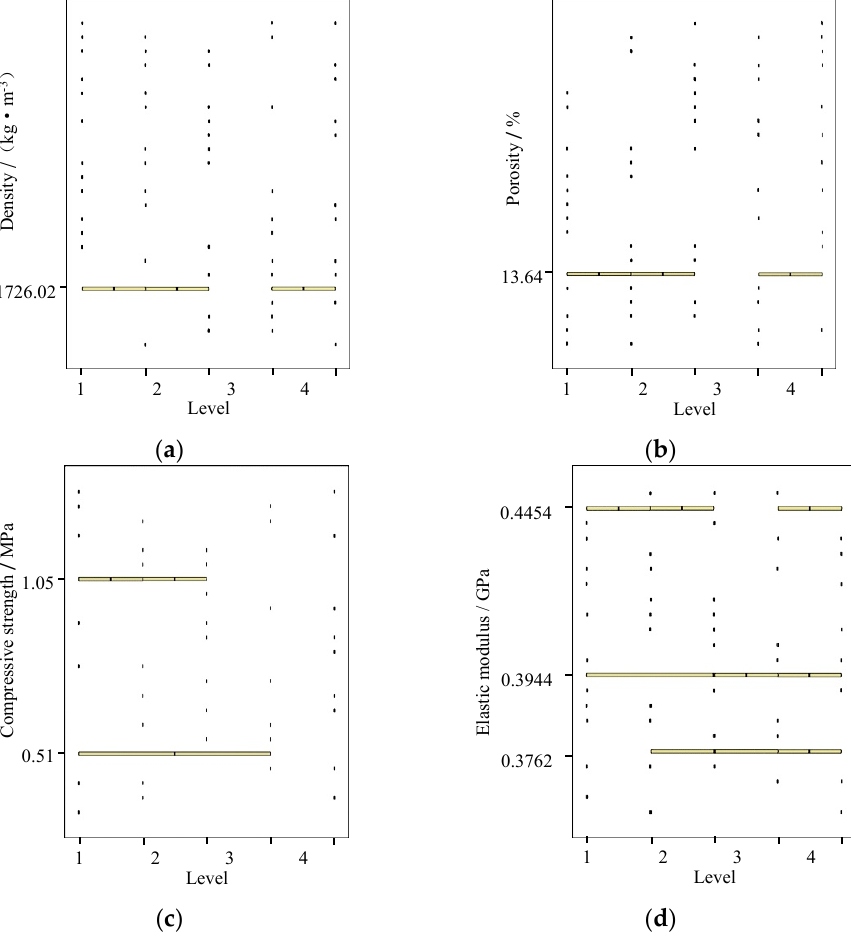
Figure 4. Outlier detection for test results. ( a ) Density. ( b ) Porosity. ( c ) Compressive strength. ( d ) Elastic modulus.